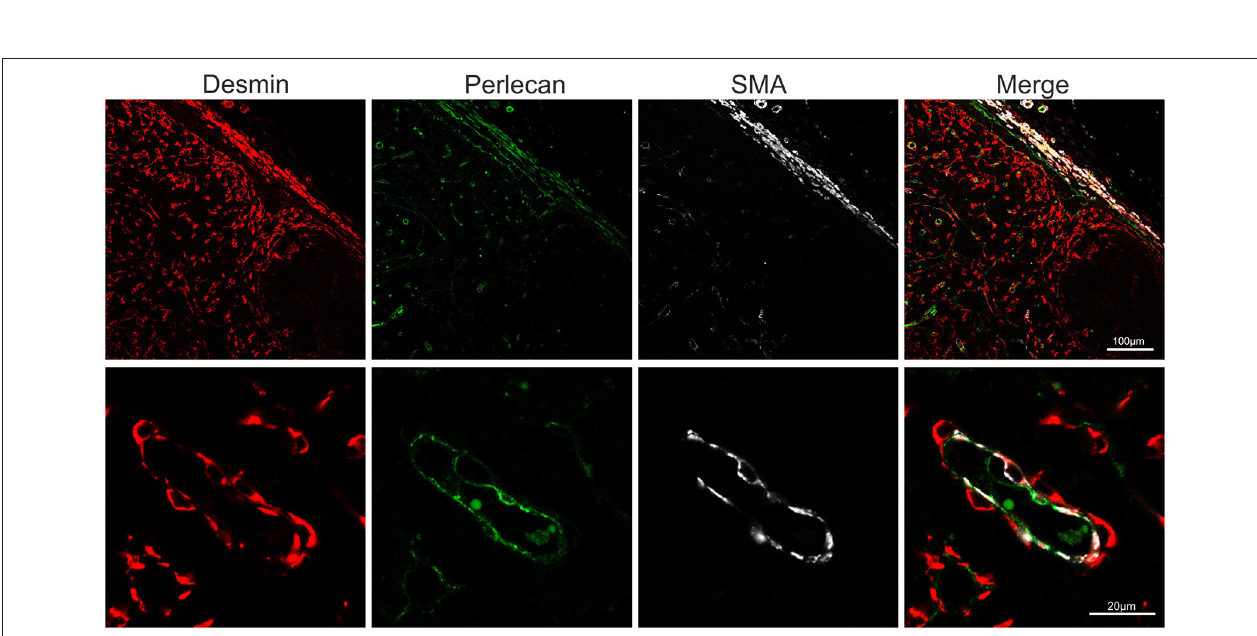
FIGURE 7 | Identification of markers for sheep endothelial cells. (A) Representative confocal microscopy micrographs of sheep lymph node (LN) sections showing the expression of Von Willebrand Factor (VWF, green) in the cortical area of the LN. WVF expression identified cells lining high endothelial venules and subcapsular sinus. Note co-expression with CD83. (B) Representative immunohistochemistry micrographs of sheep LN sections collected from uninfected control animals and fixed in formalin. Sections were stained for plasmalemma vesicle associate protein (PLVAP) identifying thin cells lining the subcapsular sinus walls and branching inside the follicles underneath.